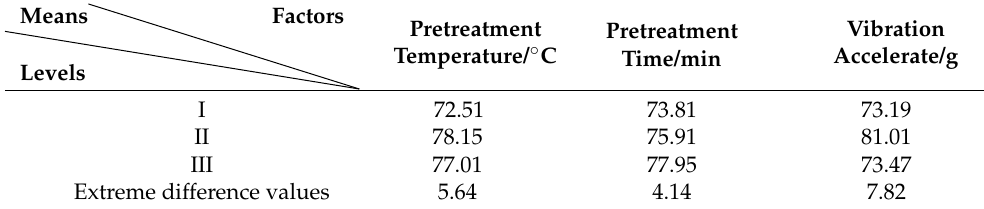
Table 3. Mean and extreme difference results of interlaminar shear strength of laminates